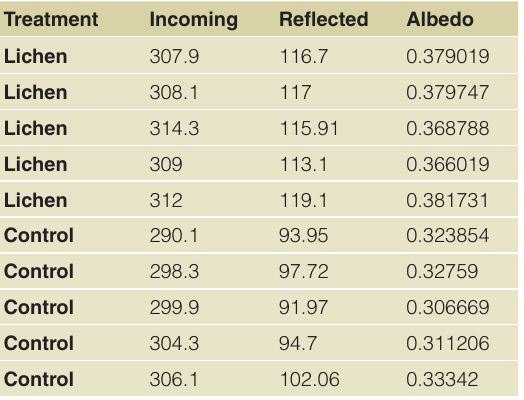
Data Set 1. Raw albedo data for the lichen modules and substrate only controls taken on September 28, 2013. Albedo was calculated by dividing the reflected radiation (Wm -2 ) by the incoming radiation (Wm -2 ). Treatment